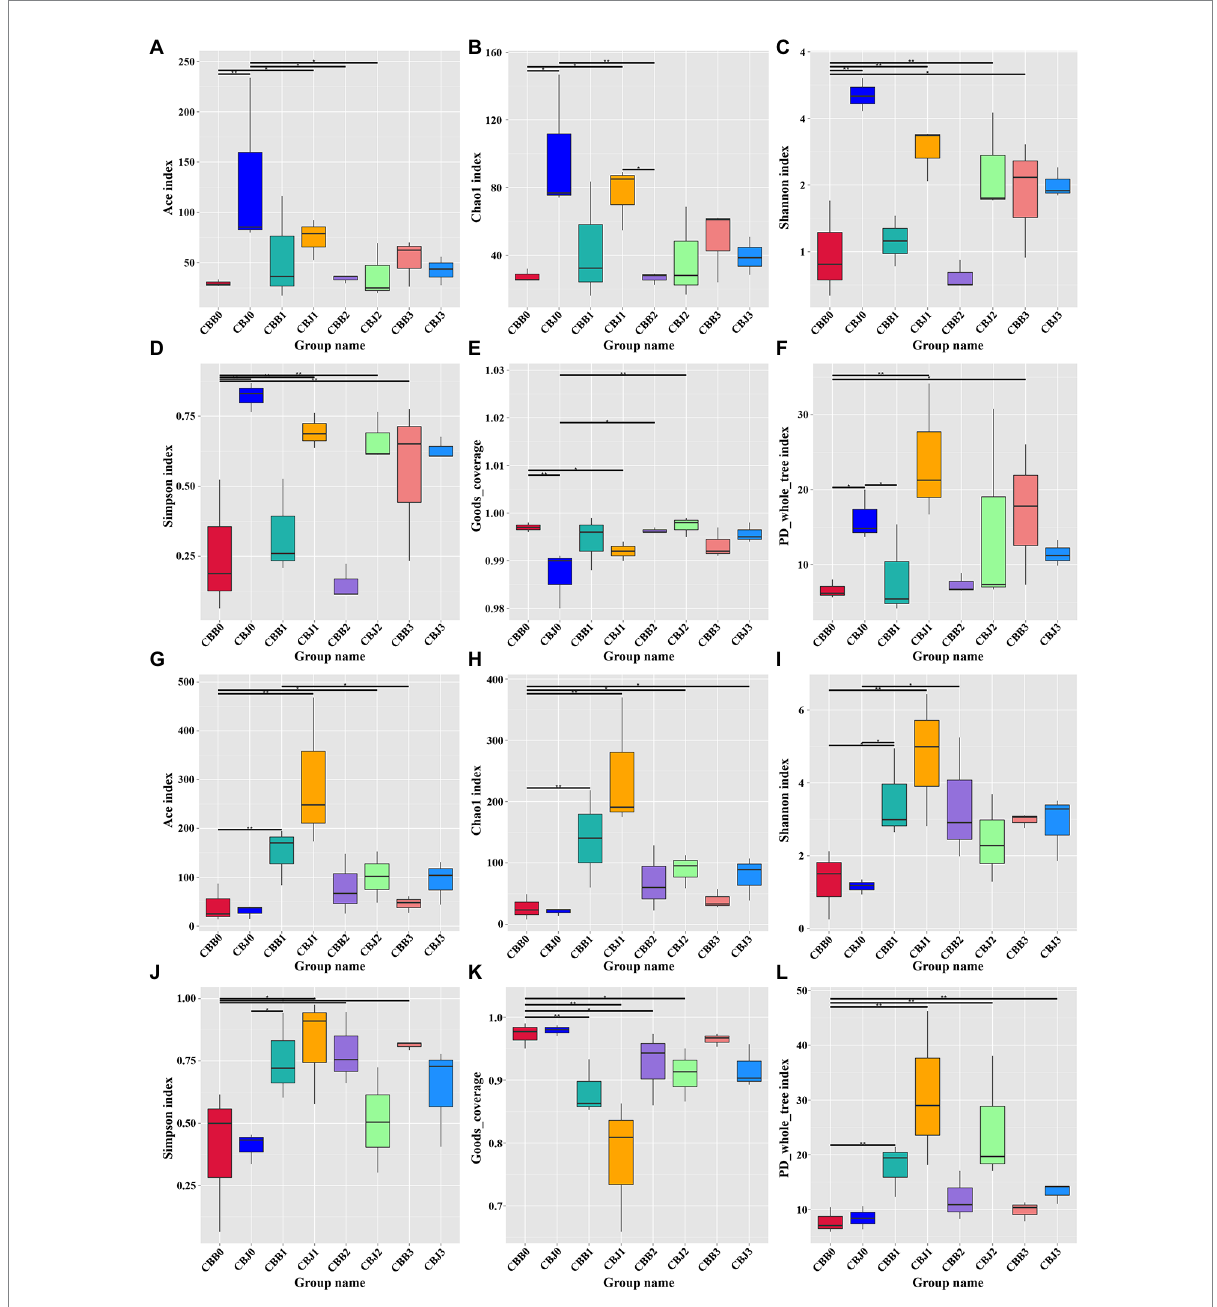
FIGURE 4 Alpha diversity of the microbial ( A–F for fungal, G–L for bacterial) communities in tobacco leaves (symptomatic leaves CBB; asymptomatic leaves CBJ) at four sampling time points (0–3). (A,G) Show the Ace index; (B,H) show the Chao1 index; (C,I) show the Shannon index; (D,J) show the Simpson index; (E,K) show the Goods_coverage; and (F,L) show the PD_whole_tree index. “*” represents a statistical difference between groups ( p < 0.05), “**” represents a significant statistical difference between groups ( p < 0.01; Wilcoxon Signed Rank